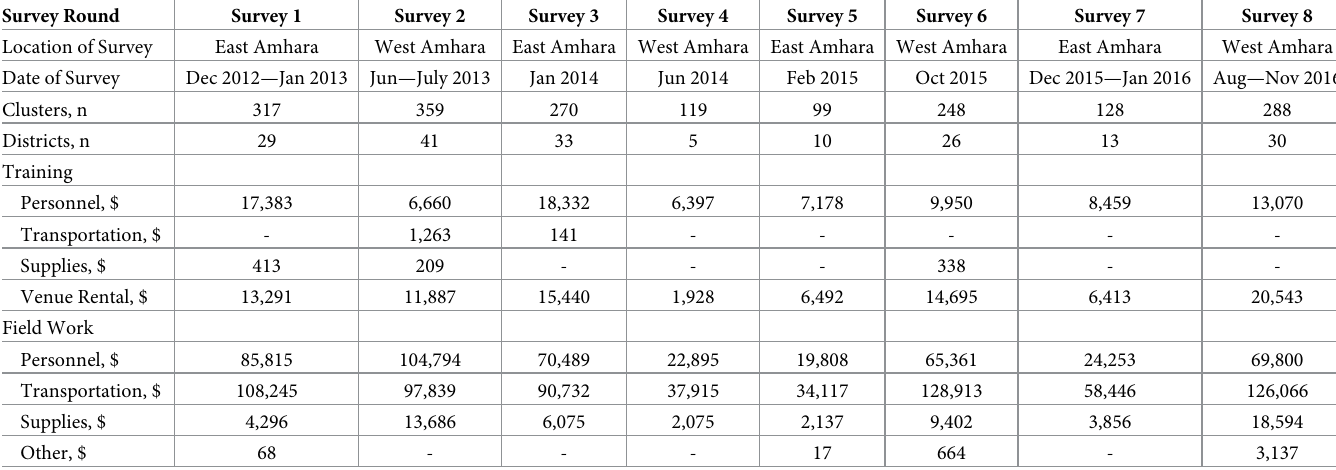
Table 3. Total costs of trachoma impact and surveillance surveys by activity and input, Amhara, Ethiopia, 2012–2016.